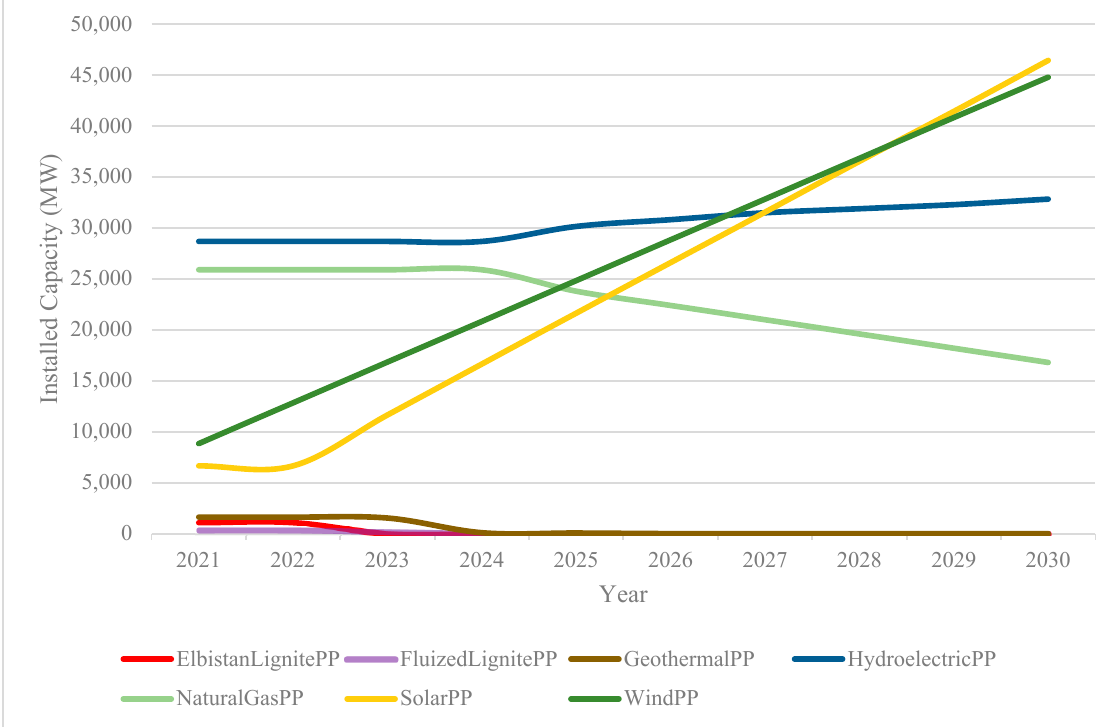
Figure 4. Installed capacities for the first scenario in the 2021–2030 horizon.